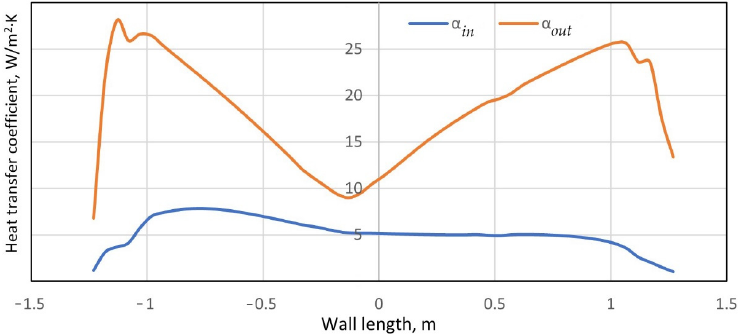
Figure 8. Heat transfer coefficients on the left wall .